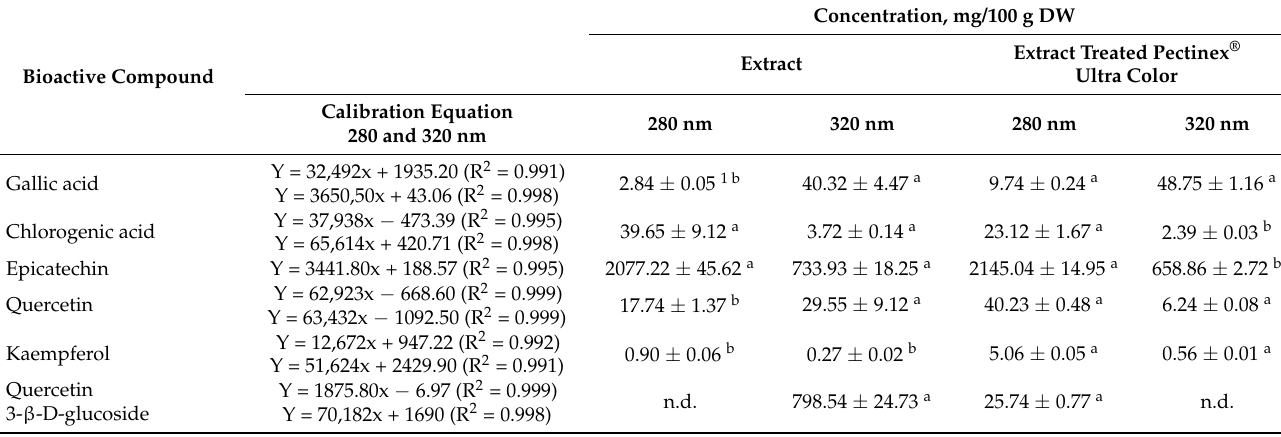
Table 1. Flavonoids and polyphenols from rosehip’s